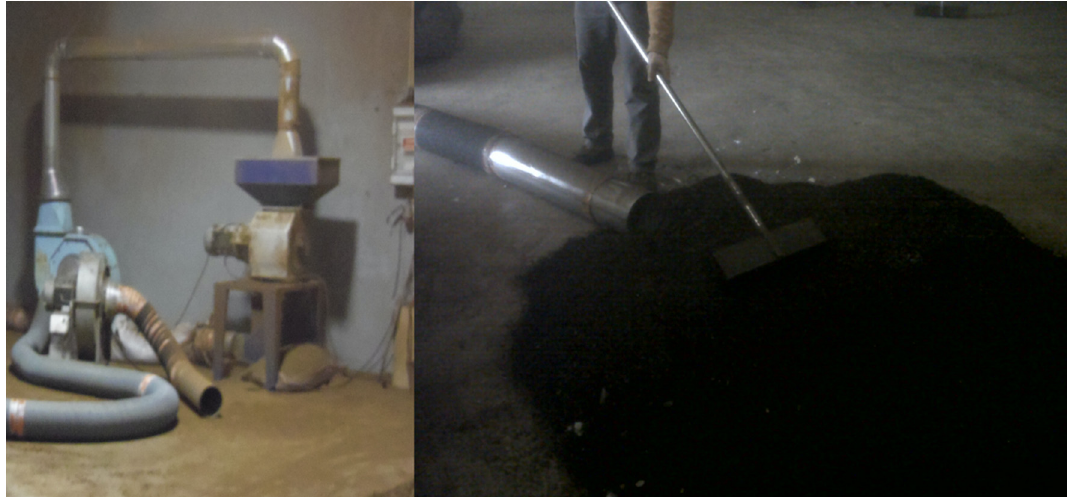
Figure 2. Left: the suction unit and the feed to the hammer mill. The material after grinding is sent to the intermediate storage silo to supply the pelletizer. Right: suction of the torrefied material into the grinding system.